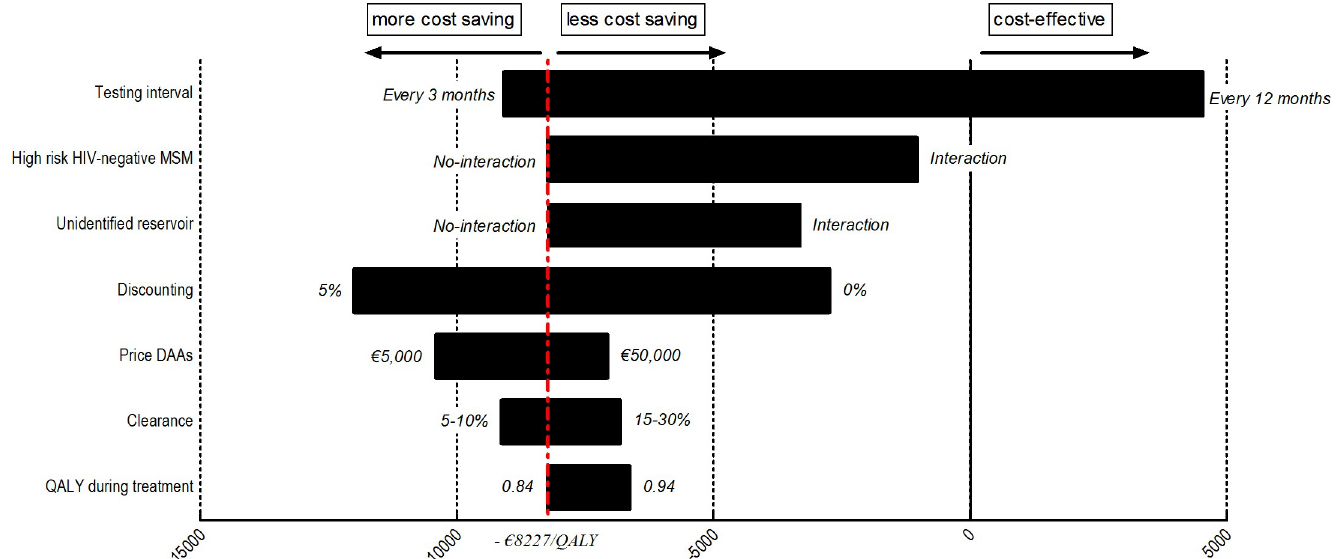
Fig 2. One-way sensitivity analysis of the incremental cost-effectiveness ratio(ICERs) ( € /QALY) of direct acting antiviral treatment (DAA). – DAA Treatment in the acute stage of infection is compared to delayed F2 DAA treatment with varying different key parameters. The bars show the range in ICER if these key variables are varied. All ICERs are stated in euros. Abbreviations: DAA: direct-acting antivirals, ICER: incremental cost-effectiveness ratio, MSM men-who-have-sex-with-men.